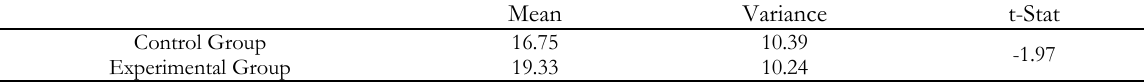
Table 3. Comparative posttest performance of the